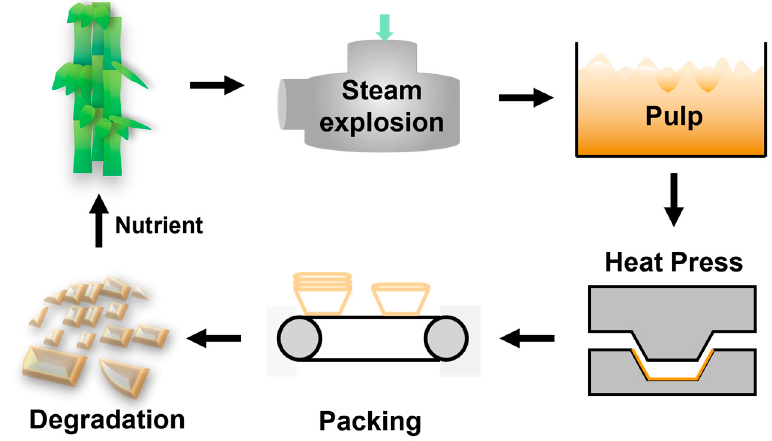
Figure 1. Preparation and degradation of an environmental-friendly bamboo fiber lunch box.